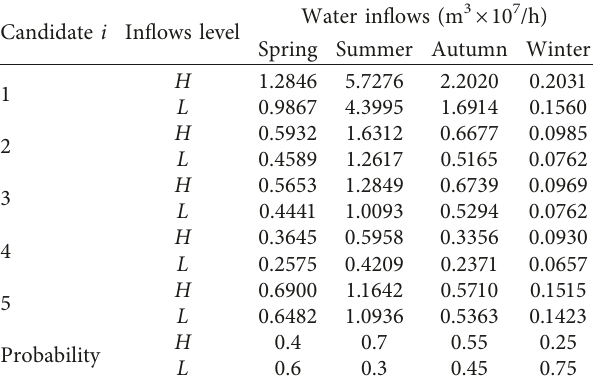
Table 5: Random water inflows in each seasonal stage of each hydropower station candidate.